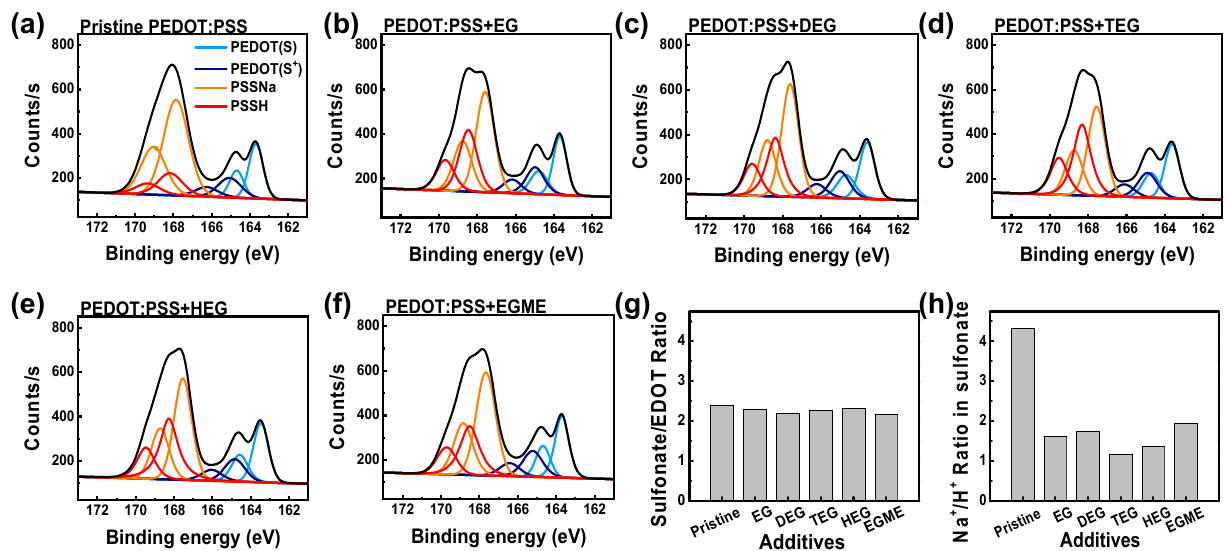
Figure 3. XPS S(2p) spectra of PEDOT:PSS films processed with various additives at 1 M: ( a ) Without additive and with ( b ) EG, ( c ) DEG, ( d ) TEG, ( e ) HEG, and ( f ) EGME. ( g ) Ratios of sulfonate to EDOT monomer using the areal ratios of deconvoluted peaks of the XPS signals. ( h ) Ratios of PSSNa/PSSH.